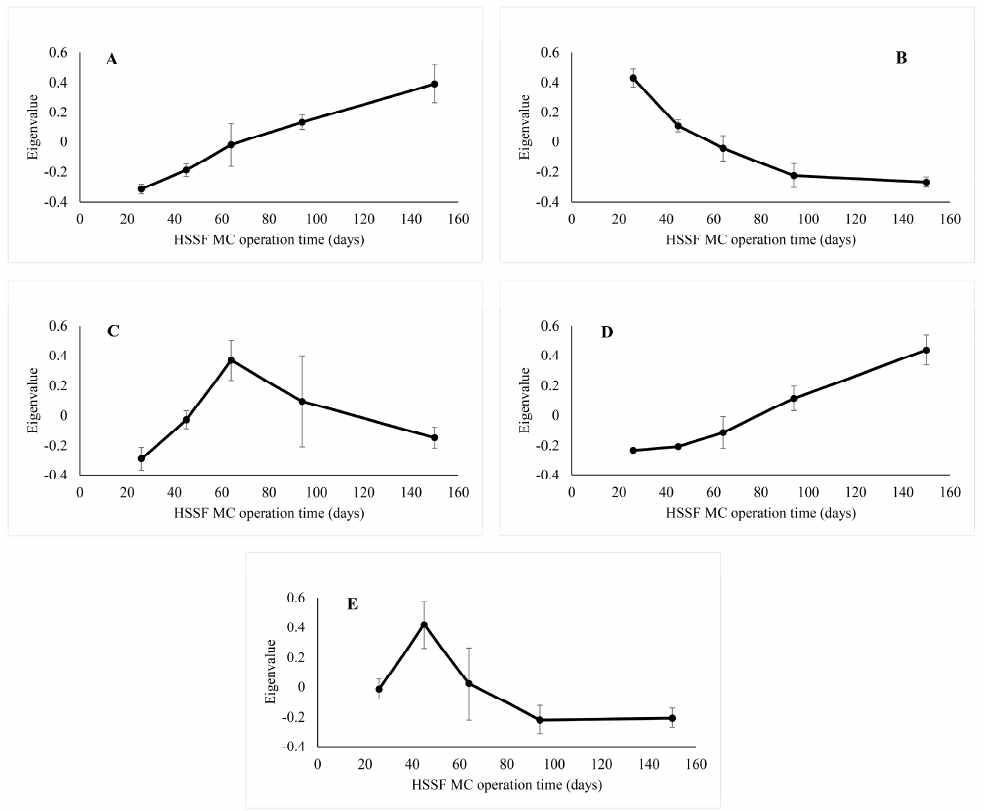
Figure A4. The temporal dynamics of eigenvalues for molecular ecological network modules, marked as ( A )–( E ). Shown are average values of replicate units and standard deviations ( n =